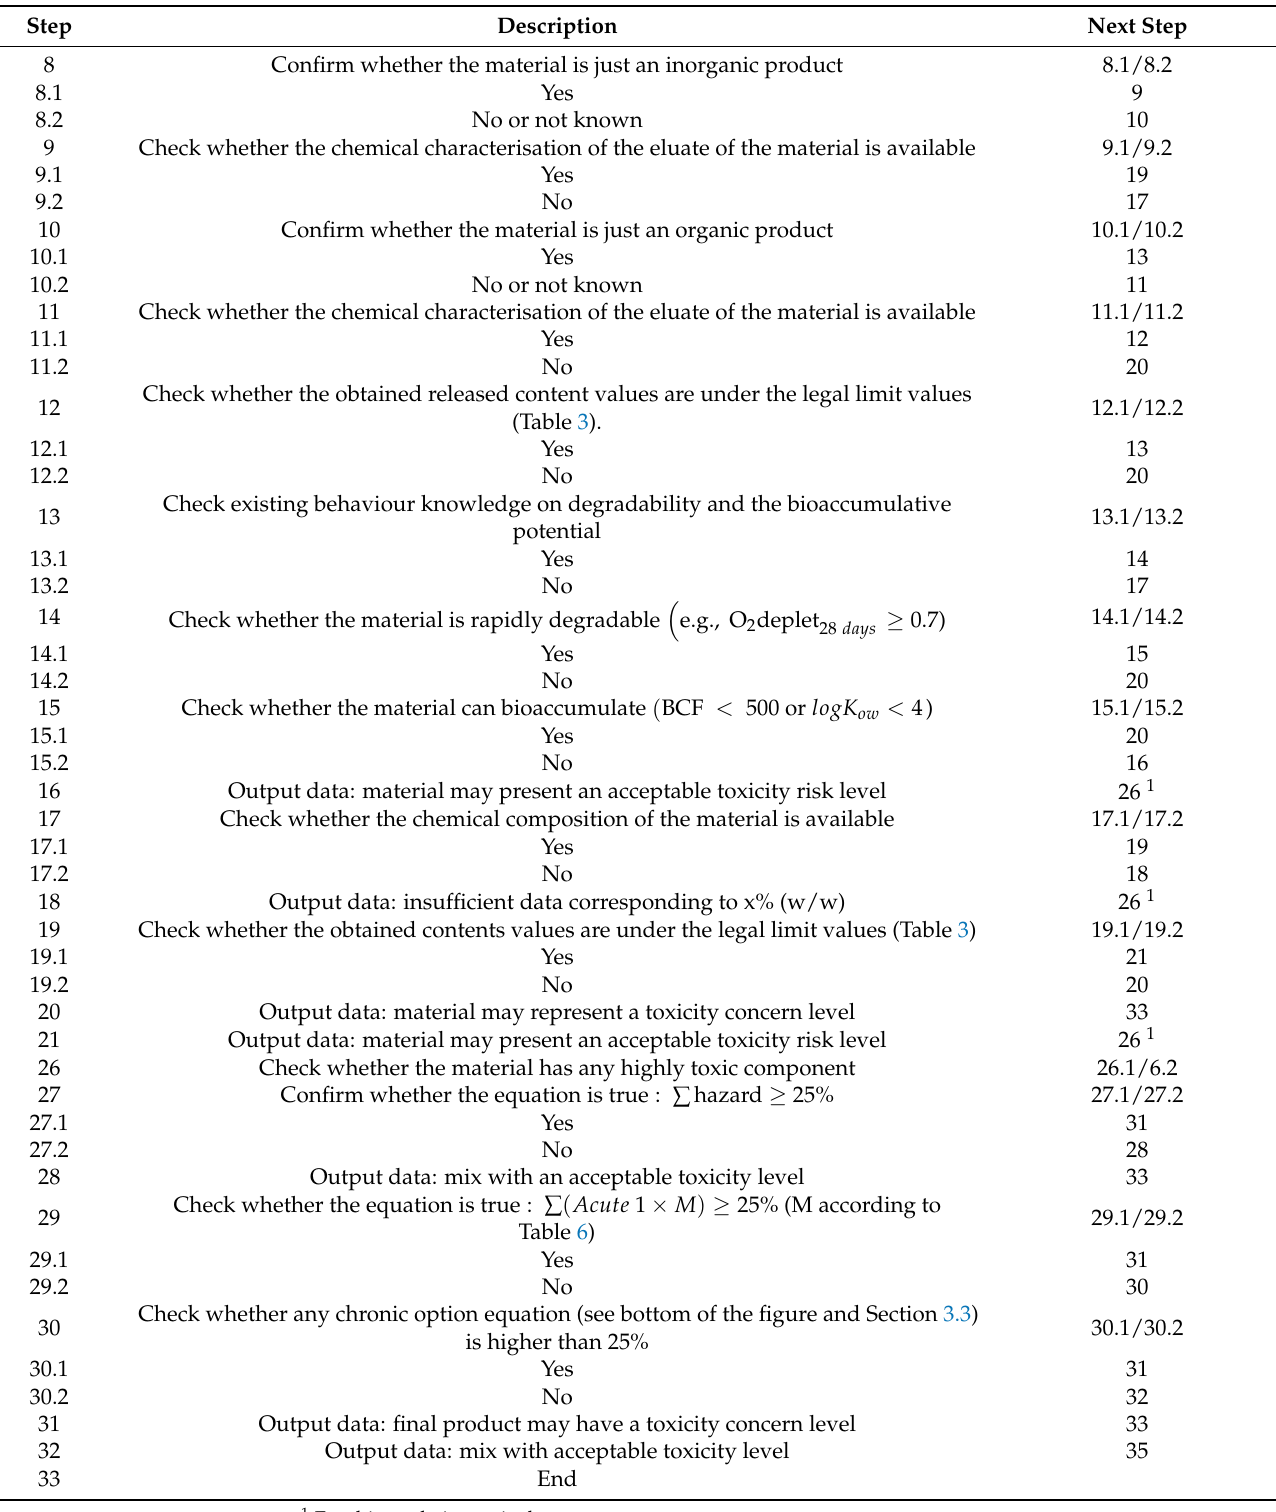
Table A2. Criteria for the application of the methodology (adapted from